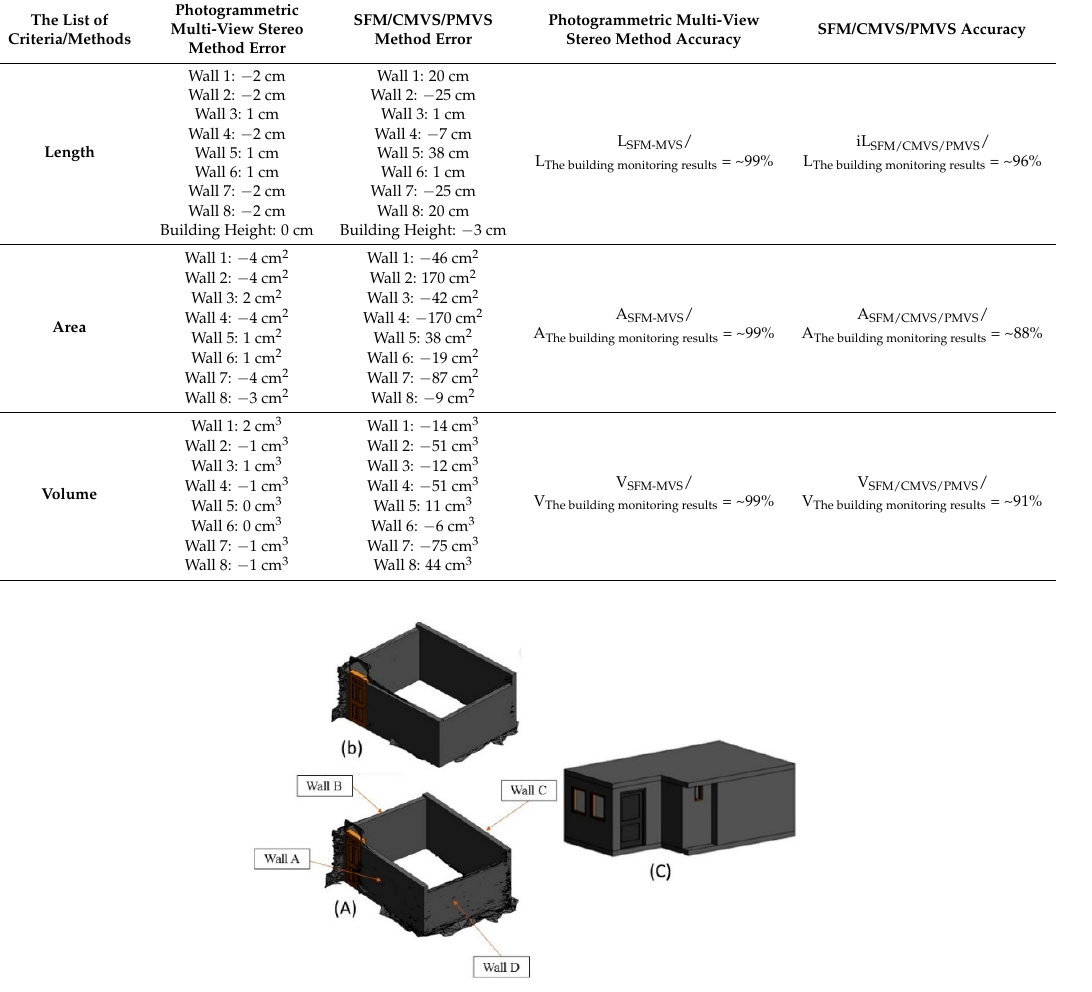
Figure 9. Case study 1: Generated as ‐ built model vs as ‐ planned model. ( a ) The as ‐ built building information model (BIM) generated by the proposed photogrammetric Multi ‐ View Stereo method, ( b ) The as ‐ built model generated by the Structured ‐ from ‐ Motion/Clustering Multi ‐ Views